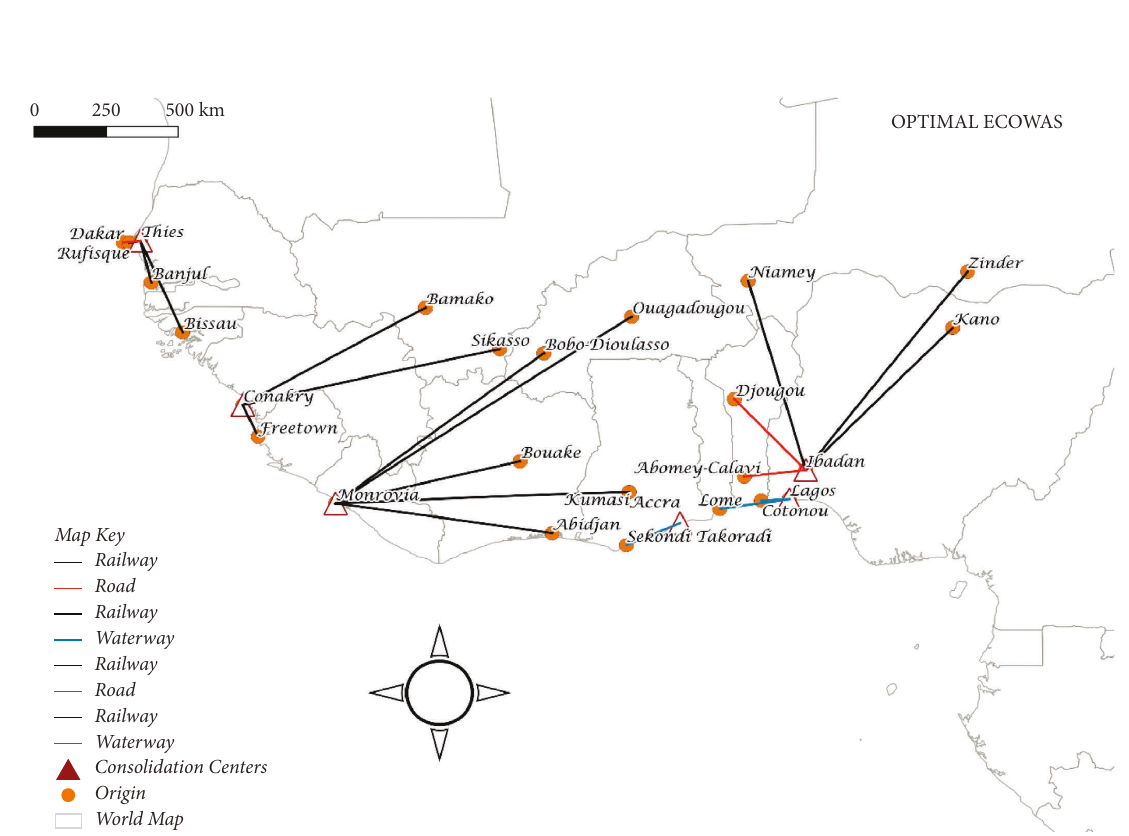
Figure 5: Optimal ECOWAS for logistic network.